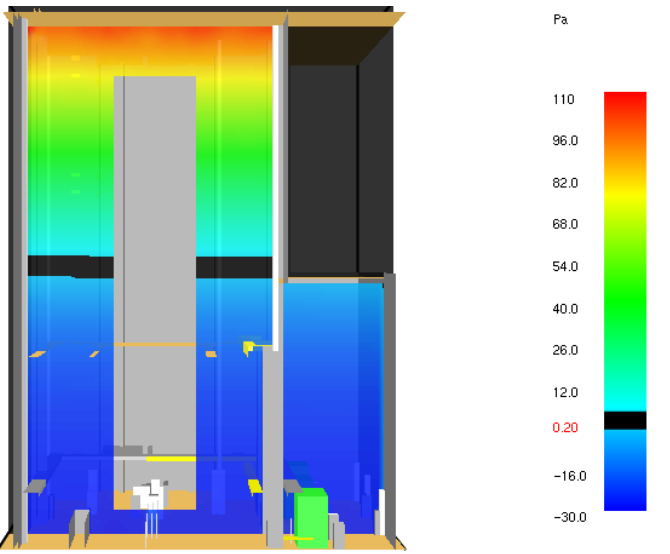
Figure 6. Position of the neutral plane and pressure distribution during a fire, without ventilation.